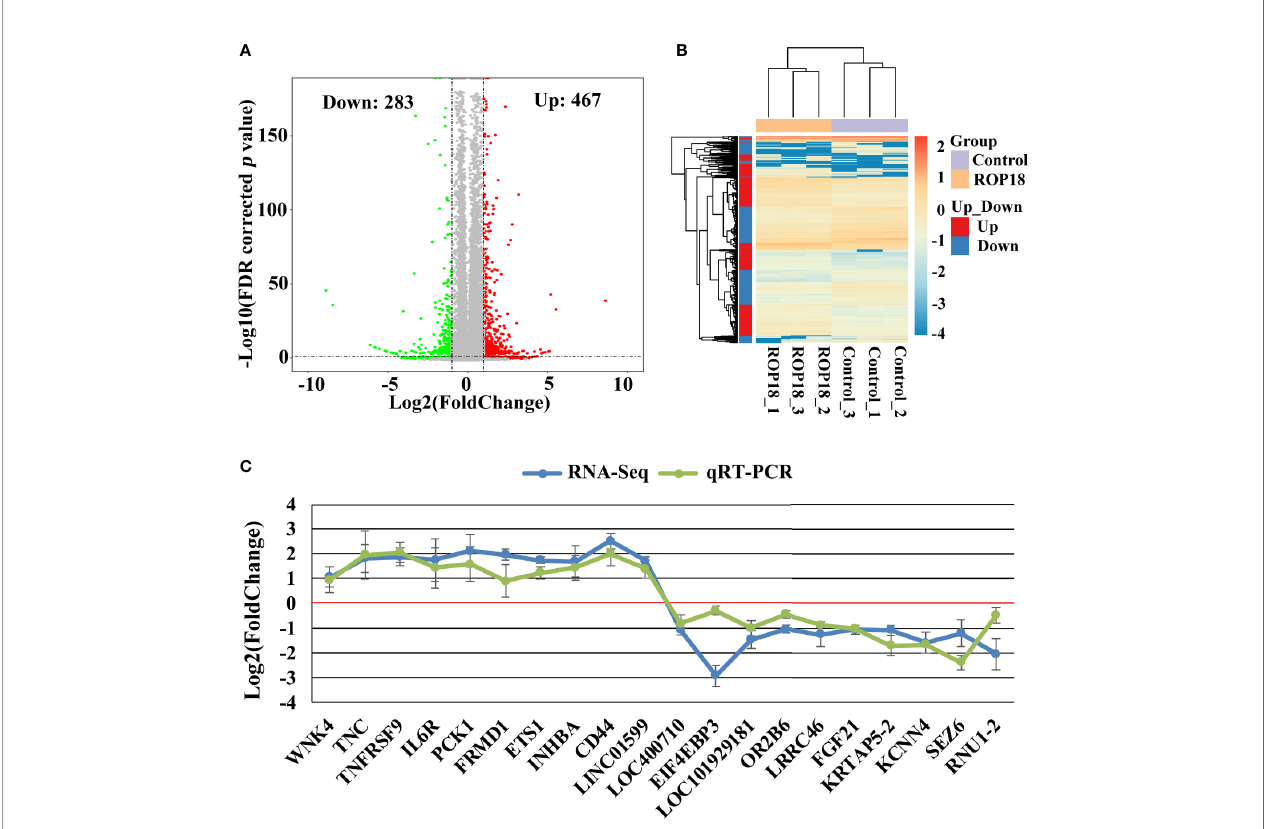
FIGURE 2 | Differentially expressed genes (DEGs) and qRT-PCR validation. (A) Volcano plot showing gene expression changes in ROP18-expressing HEK293T cells, including 467 upregulated genes and 283 downregulated genes. Red and green colors represent upregulated and downregulated genes, respectively. (B) Clustering analysis of DEGs and samples. The color scale bar for heat intensity indicates Log 2 (Fold Change); up and down indicate upregulated and downregulated genes in ROP18-expressing cells, respectively. Columns, samples; rows, DEGs. The samples were grouped into two distinct clusters: ROP18- expressing group and control group. (C) qRT-PCR validation of the RNA-seq results. The expressional trends of the examined DEGs were similar between qRT-PCR and RNA-seq results. Blue and green colors represent the result of RNA-seq and qRT-PCR, respectively.